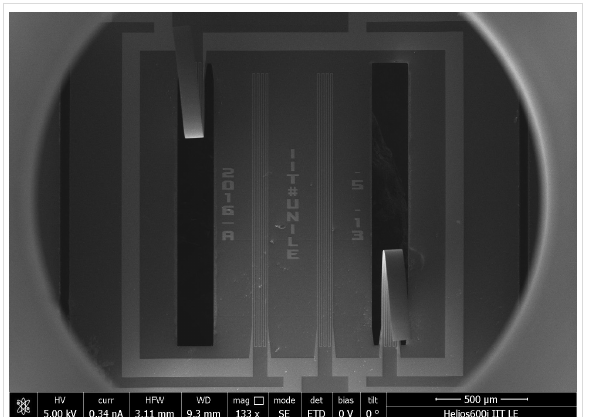
Figure 4: SEM picture of the antiparallel artificial hair sensor (top view). Four adjoined resistors, two static resistors in the centre and two bent out-of-plane strain gauges (variable resistors), form a half-bridge strain gauge